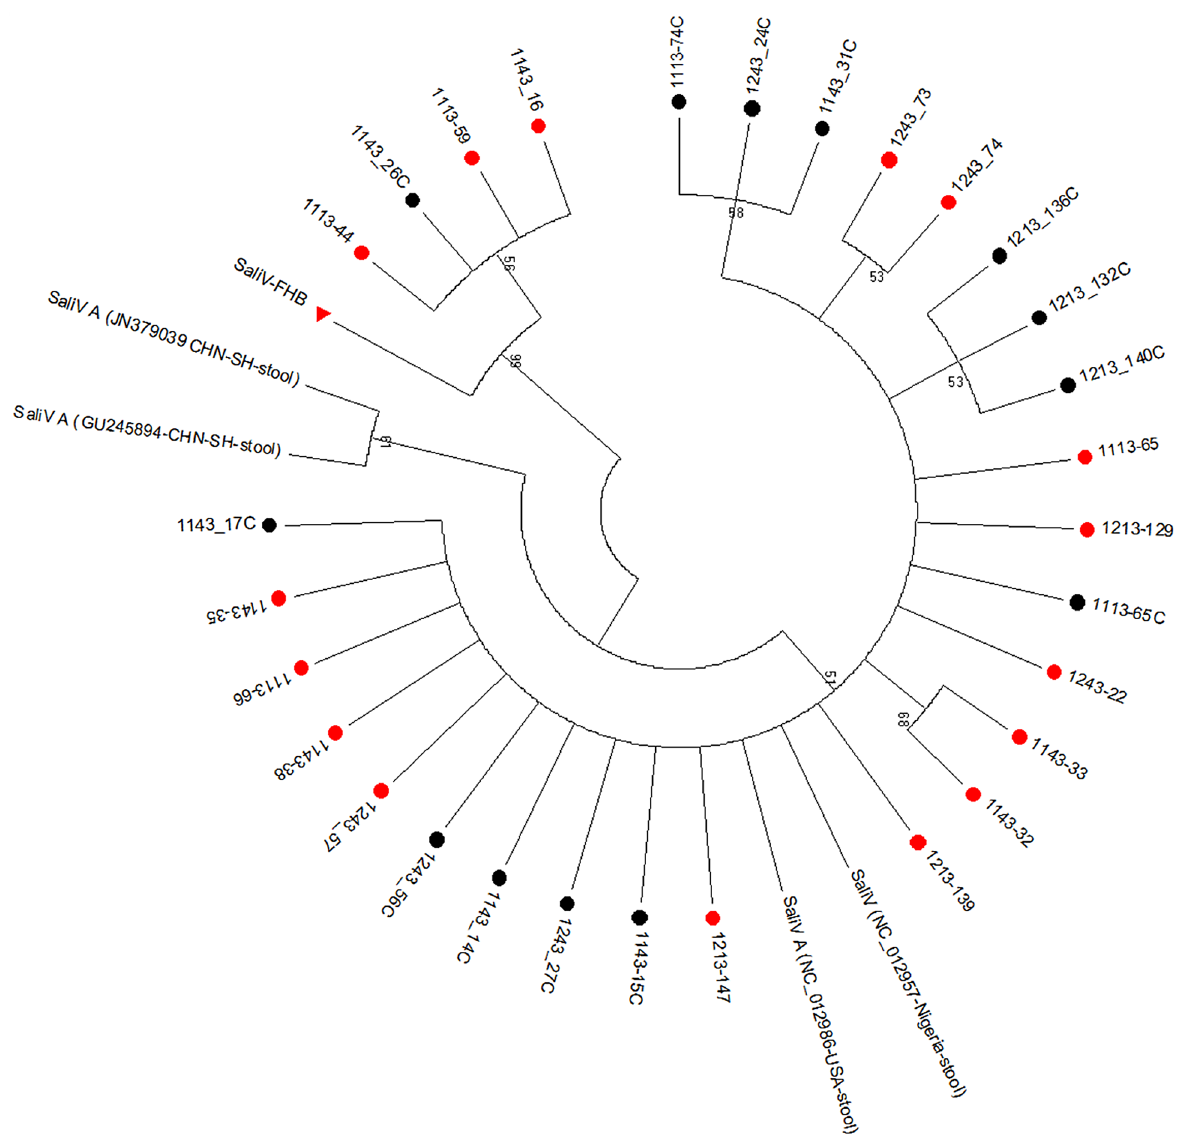
Fig 2. Phylogenetic relationships based on the 5 0 UTR sequences amplified in this study and those of other saliviruses. The sequences acquired in this study were in the same lineage. Sequences acquired from cases are marked with “ ● ” in red, while from healthy controls are marked with “ ● ” in black. SaliV-HFB is marked with “ ▲ ” in